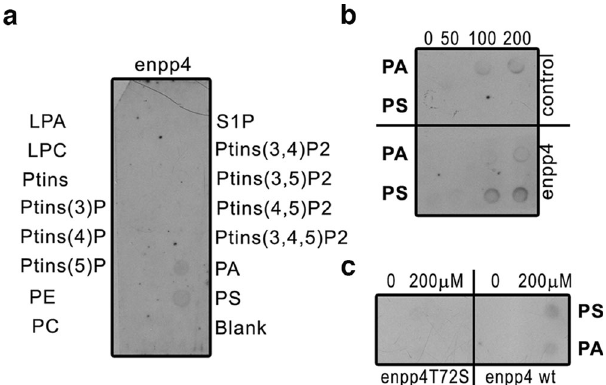
Fig. 7 Enpp4 speci fi cally binds to the lysophospholipid, phosphatidylserine. a Membrane Lipid strip TM was incubated with membrane protein extracts from Enpp4 overexpressing CHO cells and the bound Enpp4 protein detected with anti-XlEnpp4 serum. b , c Nitrocellulose membranes were spotted with increasing amount of PA or PS and incubated with membrane protein extracts from CHO cells transfected with enpp4 -pcDNA3.1, with enpp4 T72S-pcDNA3.1 or empty plasmid (control) and the bound proteins detected with anti-XlEnpp4 serum. LPA lysophosphatidic acid, LPC lysophosphocholine, PA phosphatidic acid, PC phospatidylcholine, PE phosphatidylethanolamine, PS phosphatidylserine, PtIns phosphatidylinositol, S1P shingosine-1-phosphate (see also Supplementary Fig.